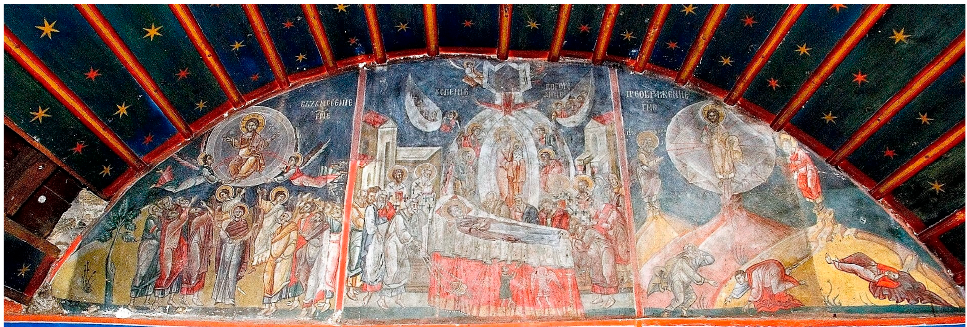
Figure 11. Dormition of the Theotokos , wall painting, 1491, Church of the Holy Apostles Peter and Paul, Orlitsa Cloister, Monastery of Saint John of Rila, Bulgaria. (Photo credit: Angel Yordanov, TerraByzantica ).